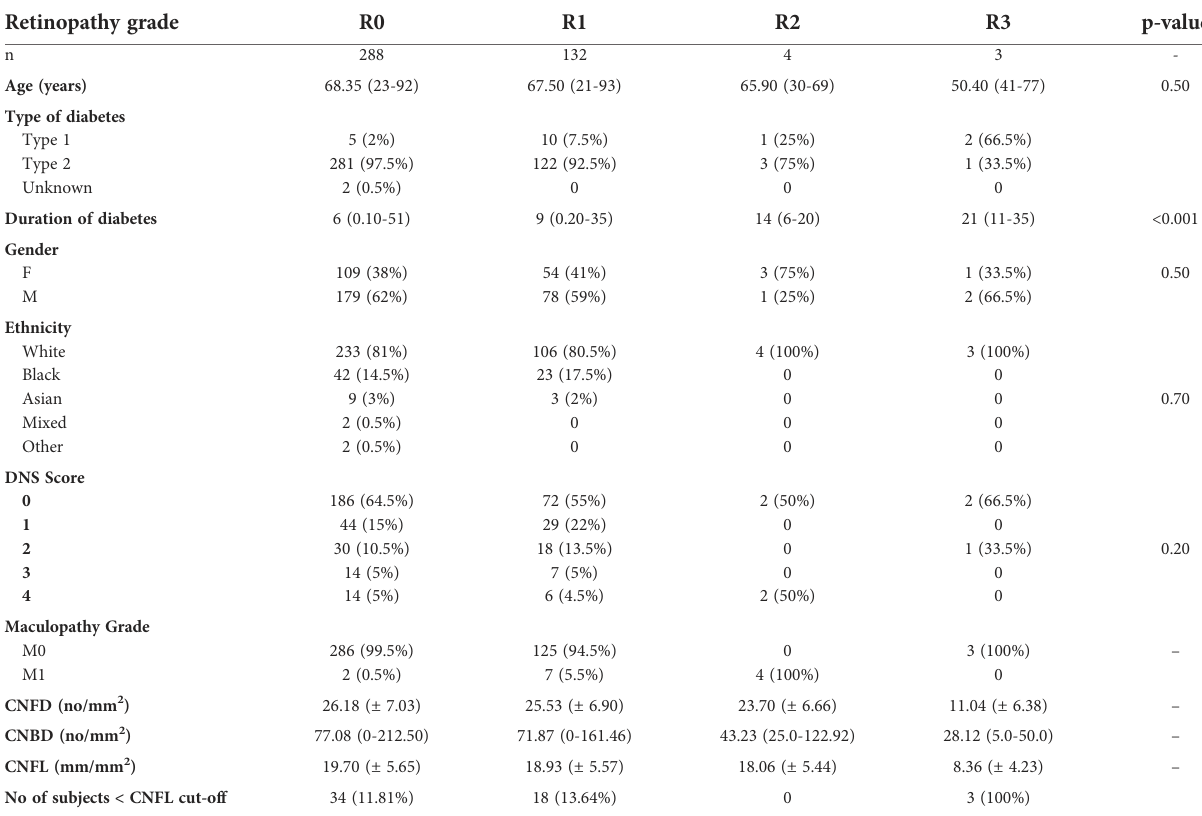
TABLE 6 Comparison of different retinopathy grades.